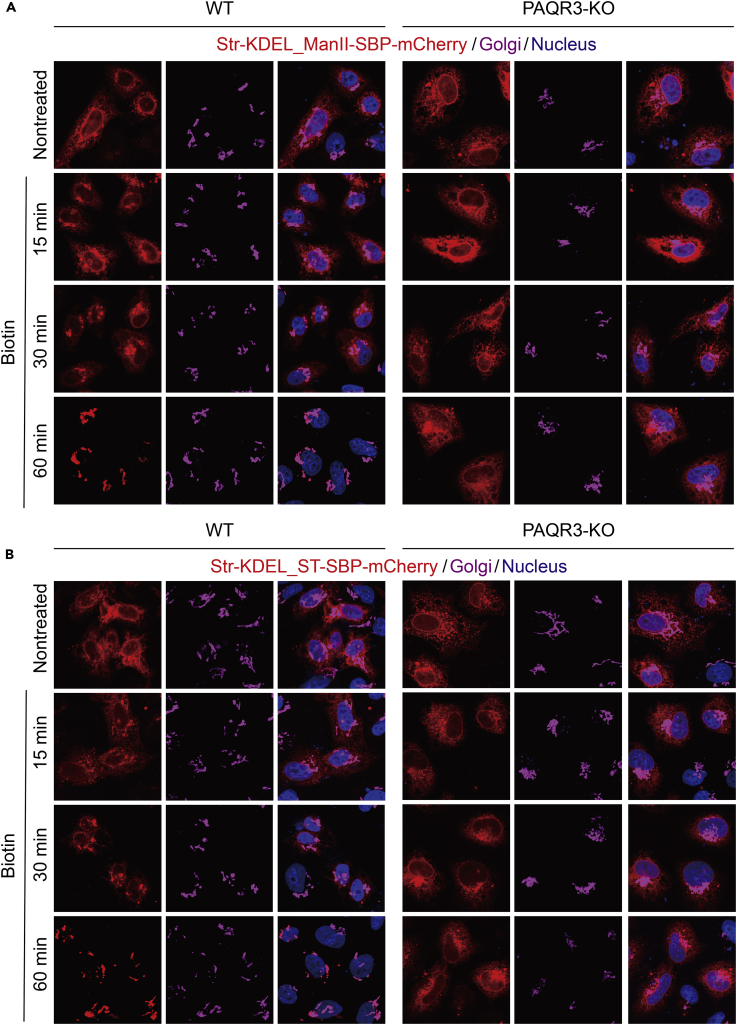
PAQR3 Deletion Reduces ER-to-Golgi Trafficking of Golgi-Reporter ST-SBP and ManII-SBP in RUSH AssayWild-type HeLa cells (WT) or PAQR3-deficient HeLa cells (PAQR3-KO) were transiently transfected with Str-KDEL_ST-SBP-mCherry plasmid or Str-KDEL_ ManII -SBP-mCherry plasmid as indicated. About 36 hr after the transfection, 40 μM of biotin was added for different times. The cells were then analyzed by fluorescence microscopy. The Golgi was stained with antibody against GM130. The nucleus was stained with Hoechst 33342. All of the images were taken with the same exposure. The analysis was repeated three independent times.